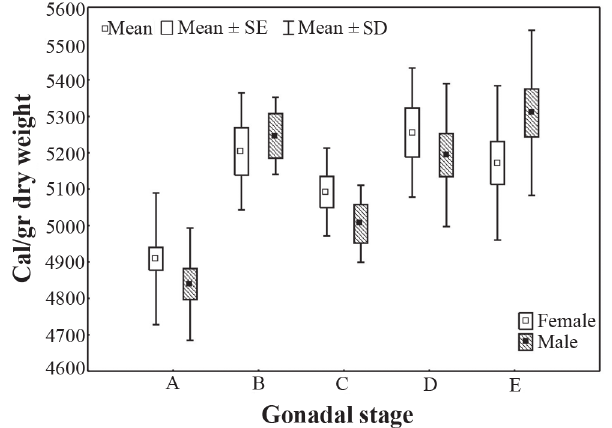
Fig. 3. Caloric mean values for the maturity stages (A = immature, B = resting, C = maturing, D = mature, E = spent) of males and females of C. kelberi , sampled in the upper Paraná River